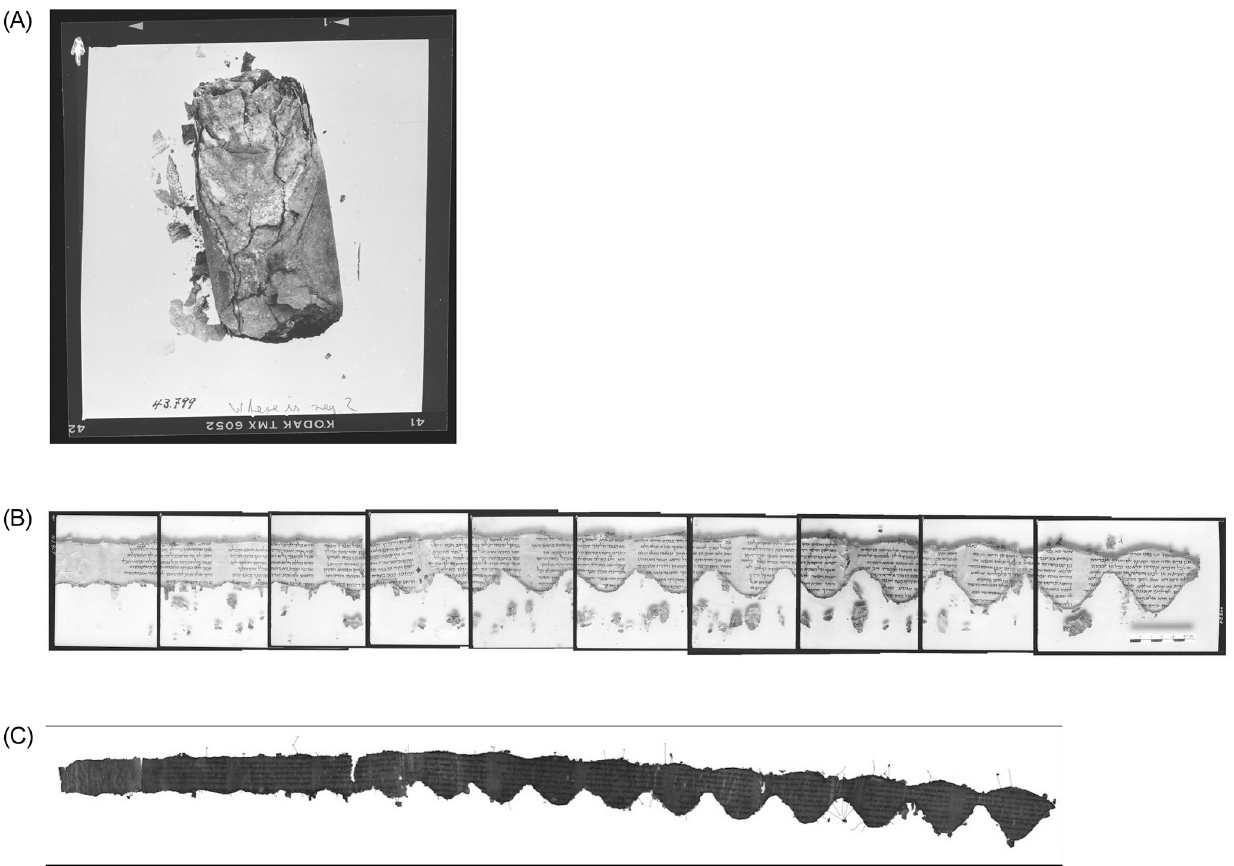
Fig 6. Targum Job , 11Q10. (A) Upper left: prior to unrolling. (B) Upper right: composite of PAM images. (C) Lower right: composite of IAA images. (Courtesy IAA, LLDSSD. IAA image photographer: Shai Halevi; PAM photographer: Najib Anton Albina.).